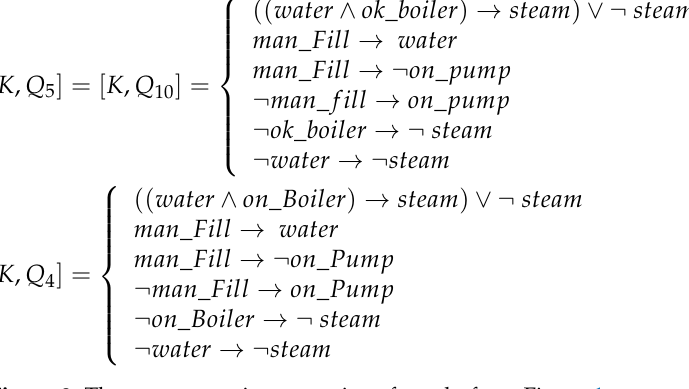
Figure 3. Three conservative retractions for w.b. from Figure